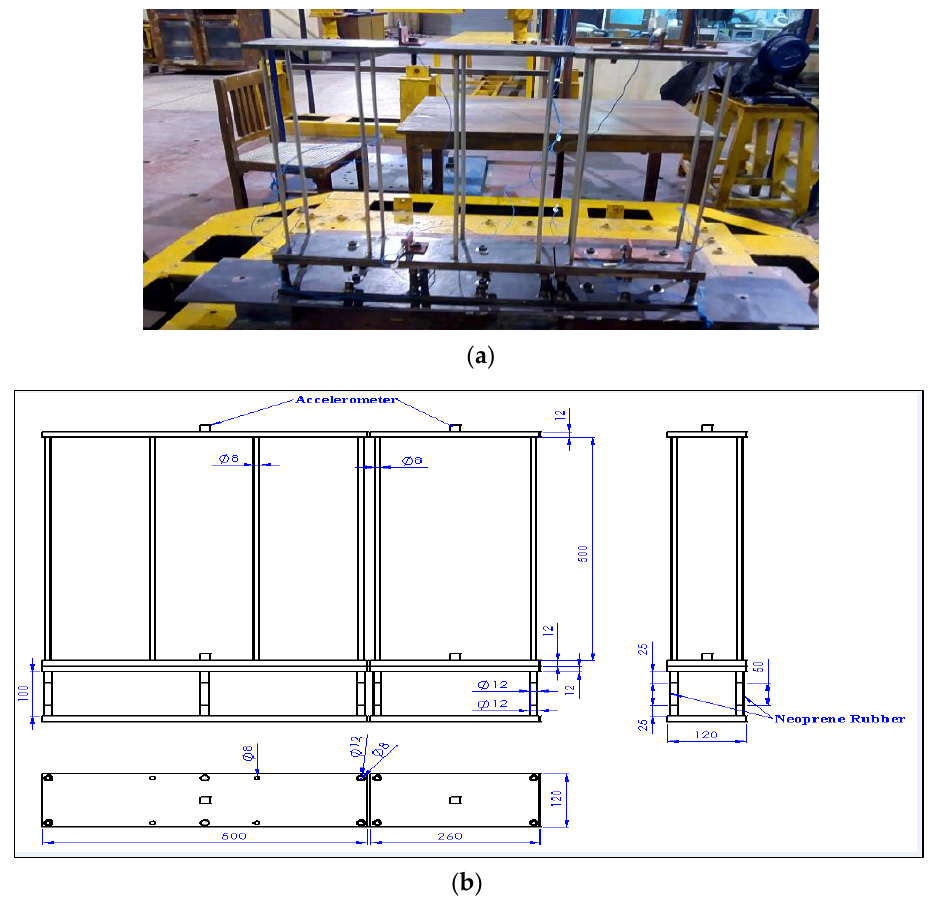
Figure 3. Base-isolated flexible models. ( a ) Experimental setup; ( b ) schematic diagram.